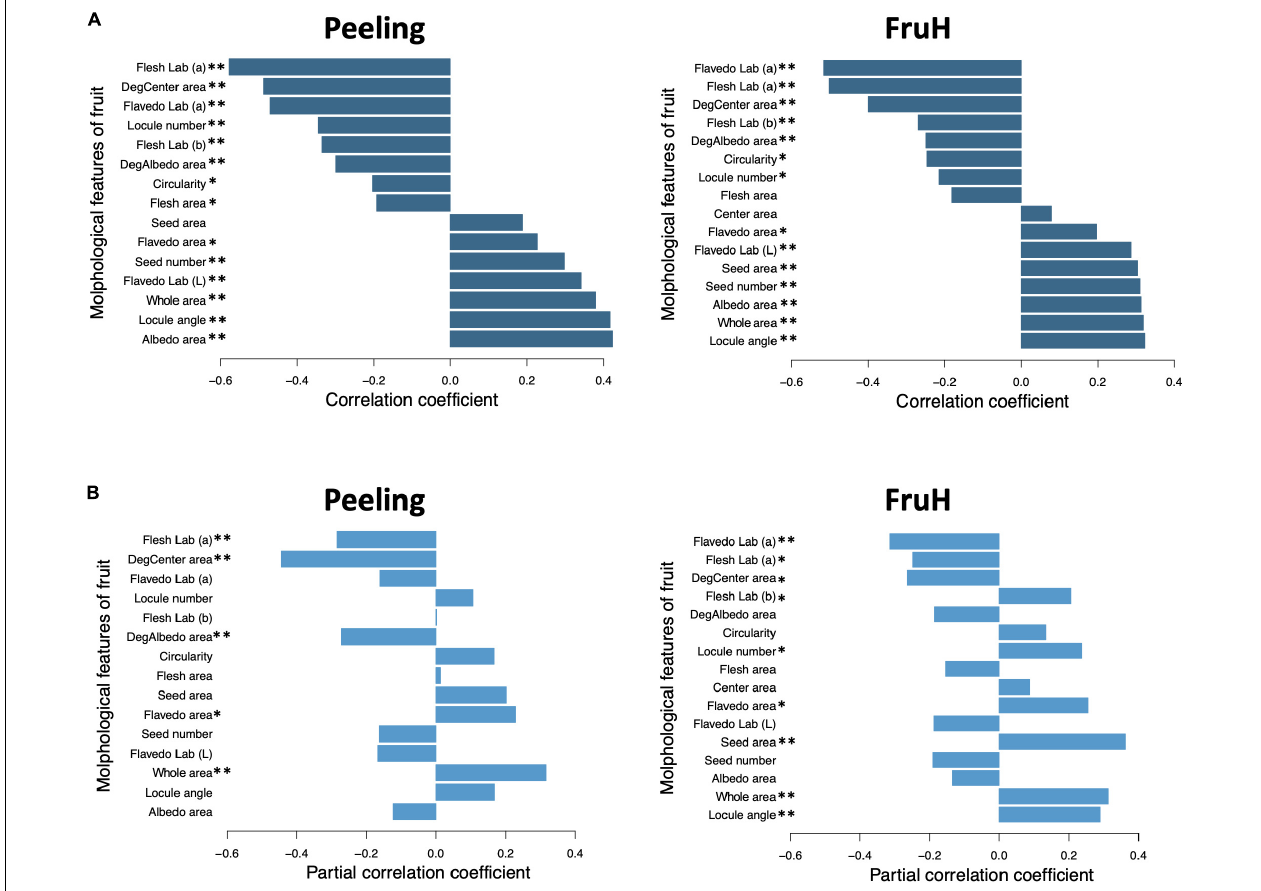
FIGURE 4 | Apparent and partial correlations between fruit morphological features and breeder-evaluated fruit quality traits. (A) Apparent correlation coefficients. (B) Partial correlation coefficients. Asterisks indicate statistically significant correlations: ∗ p < 0.05; ∗∗ p <